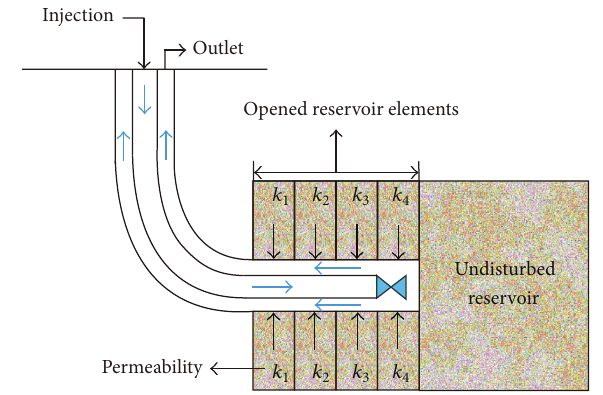
Figure 3: A schematic of a horizontal well drill into the reservoir consists of a number of independent